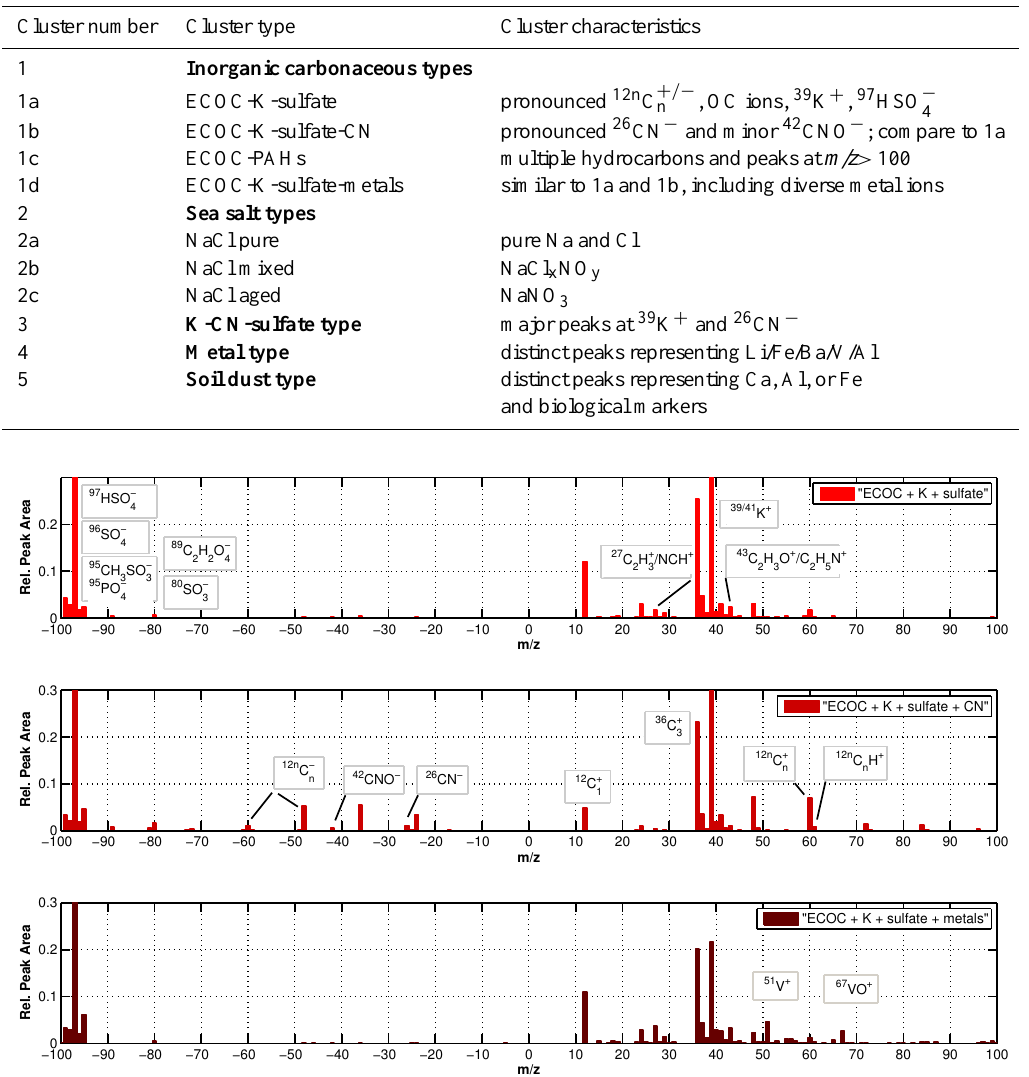
Figure 2. Mass spectra of the inorganic carbonaceous particles types obtained using the cluster algorithm ENCHILADA. The upper panel depicts the most prominent ECOC-K-sulfate type 1a. The middle one depicts the ECOC-K-sulfate-CN type 1b subject to more pronounced peaks at 12n C + n , 12n C − n , 26 CN − , and 42 CNO − . The lower panel shows type 1d with similar mass-spectrometric pattern including traces of metals. The relative peak areas of the HSO − ion are 0.83 (upper panel), 0.63 (middle panel), and 0.79 (lower panel), and those of K + are 4 0.31 (upper panel) and 0.37 (middle panel). A peak at m/z − 195 assigned to H 3 ( SO 4 ) − appears in all three spectra but, for clarity, is not 2